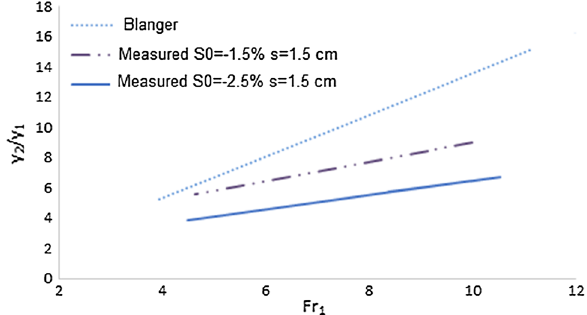
y 2 / 1 for sill-con-